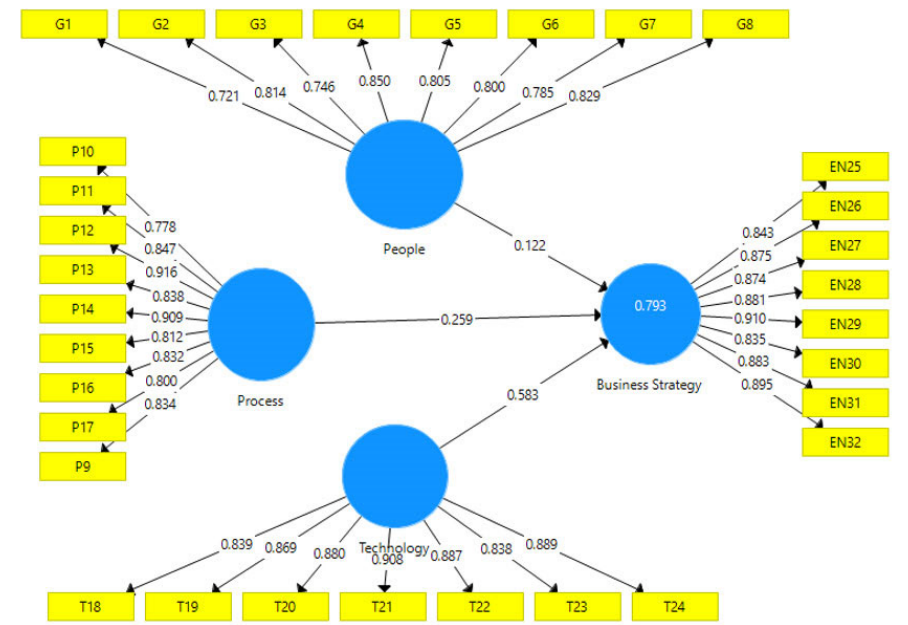
Fig. 2 . Confirmatory structural model for business